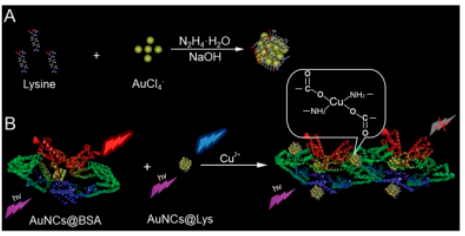
Figure 2. ( A ) Synthesis of Au NCs@Lys and ( B ) strategy for Cu 2+ detection (Copyright Ref [47], Royal Society of Chemistry).